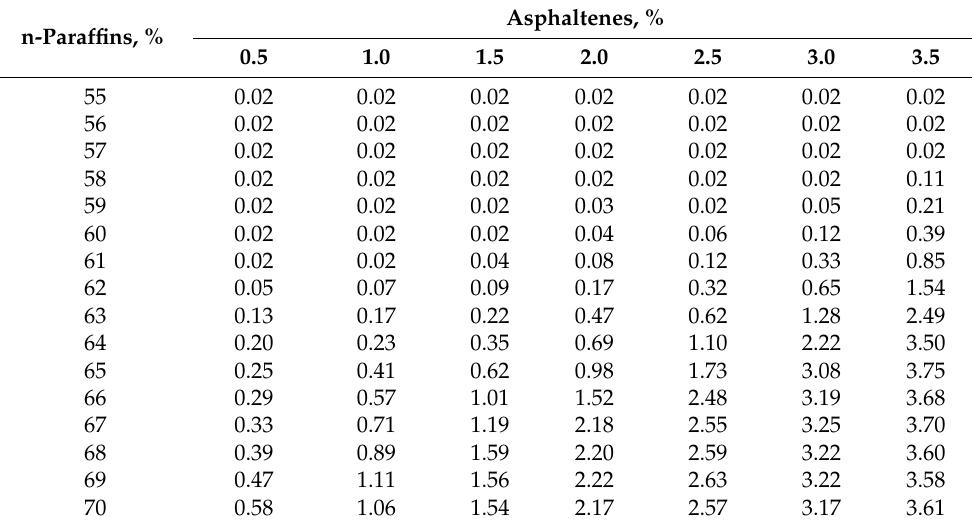
Table 4. Indicators of the influence of n-paraffins and asphaltenes on